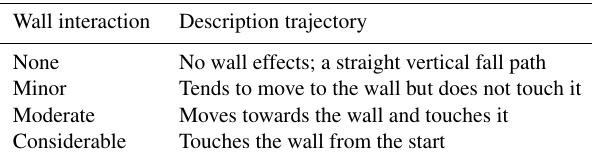
Table 6. Path trajectories of 3.0mm steel